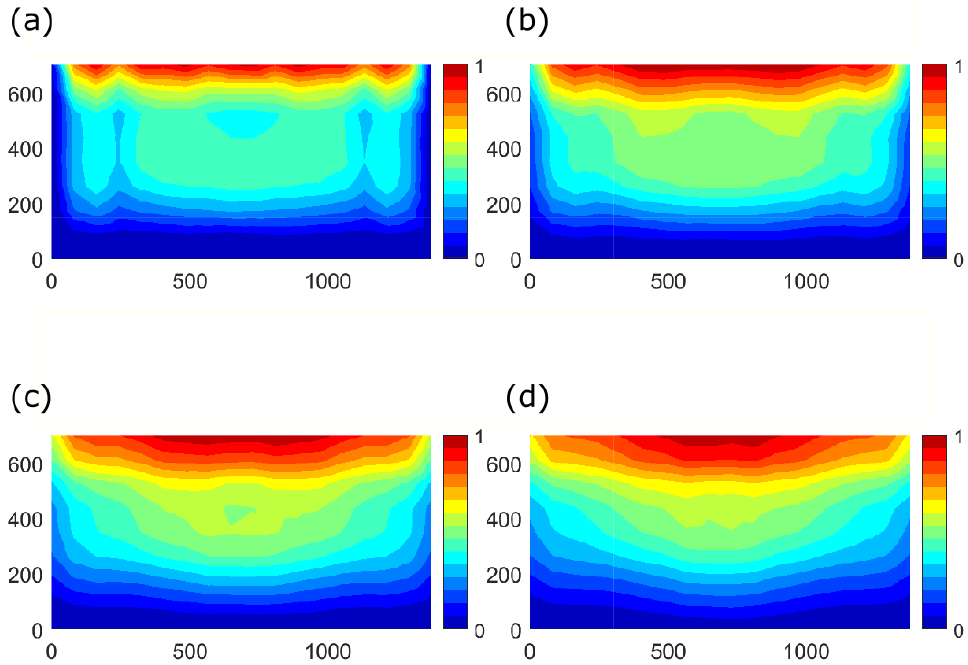
Figure 15. Normalized and mirror averaged wear maps for different amount of smoothings, ( a ) no smoothing iteration, ( b ) one smoothing iteration, ( c ) two smoothing iterations, and ( d ) three smoothing iterations. The mesh size was 75 mm, and the baseline case particles are used. Color plots are showing the normalized wear depth in